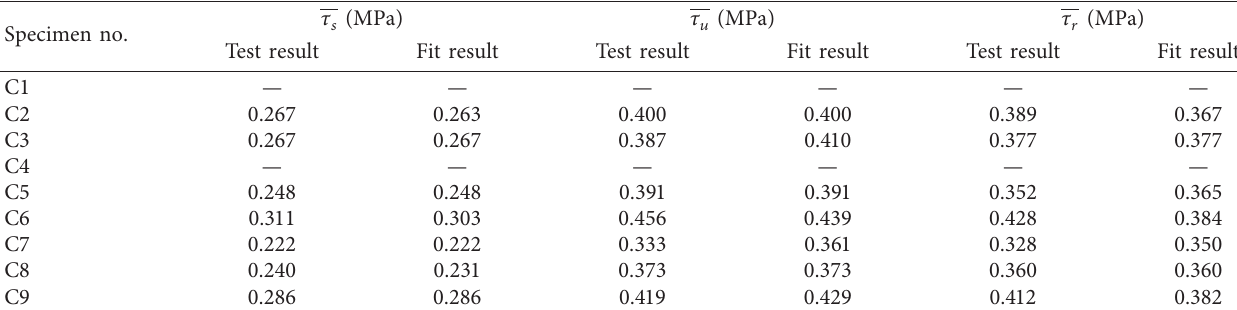
Figure 11: Relationship between τ and l Table 3: Test results and fit results of average bond strength